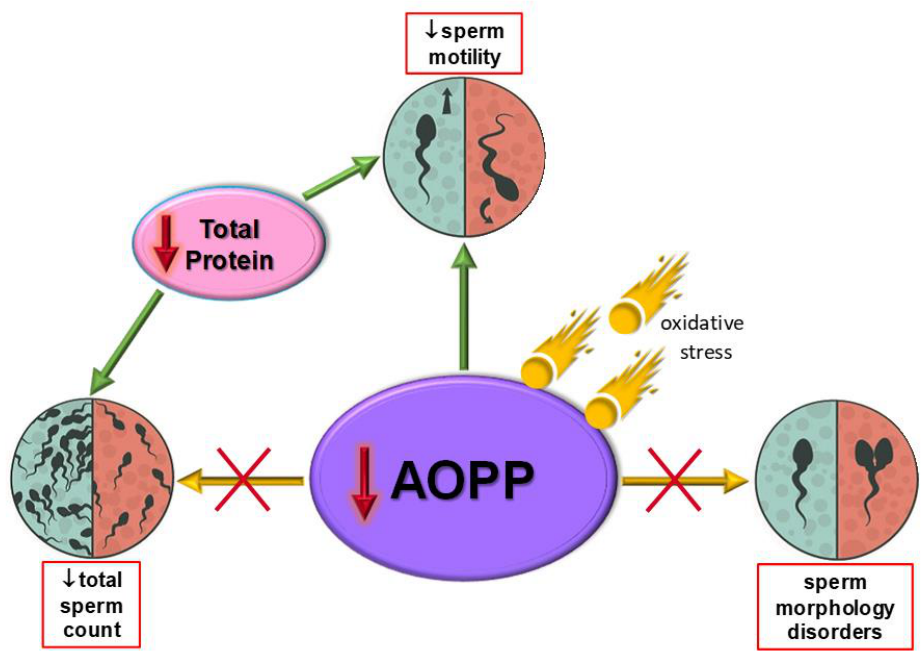
Figure 4. Relationships between the concentrations of advanced oxidation protein products (AOPP) and the levels of markers of oxidative-antioxidant balance in relation to semen parameters.